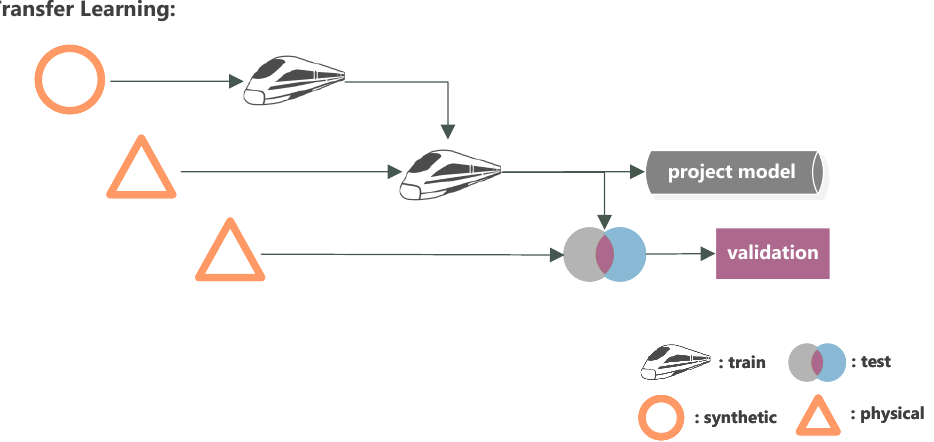
Figure 8. Combined benchmark. A network is firstly primed with the synthetic data extracted from the 3D CAD files. Afterwards, the model is updated with parts from real-world surveys and validated on holdout data. For this benchmark, various amounts of real-world data are used for